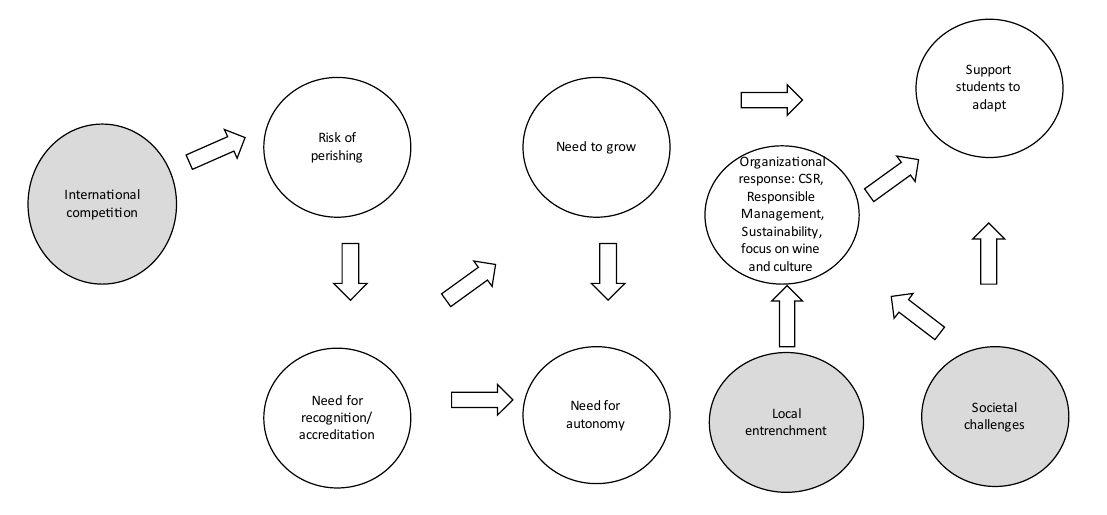
Figure 2. Institutional motivations of BSB.